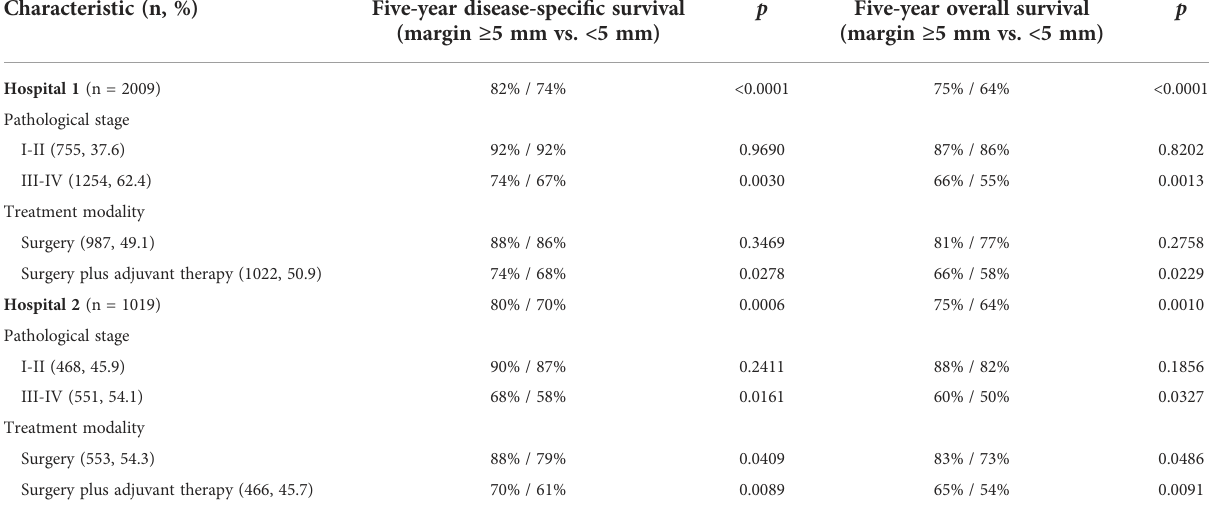
TABLE 5 Impact of surgical margin status on fi ve-year disease-speci fi c and overall survival rates in the internal grouping (pathological stage and treatment modality) of Hospital 1 and Hospital 2. Characteristic (n, %)